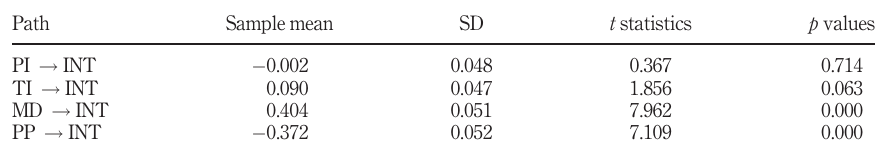
Table 2. Coef fi cients of the